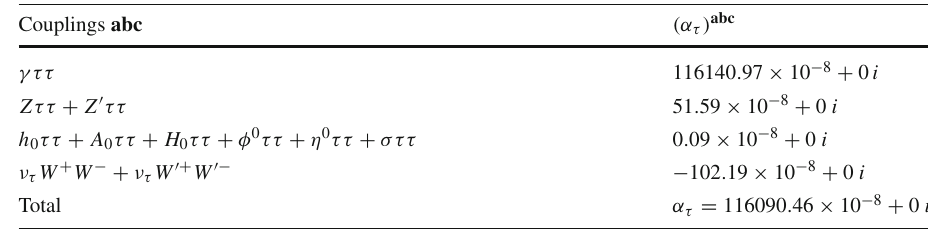
Table 6 Partial contributions to α τ . abc denotes the different particles running in the loop of the vertex γτ + τ −